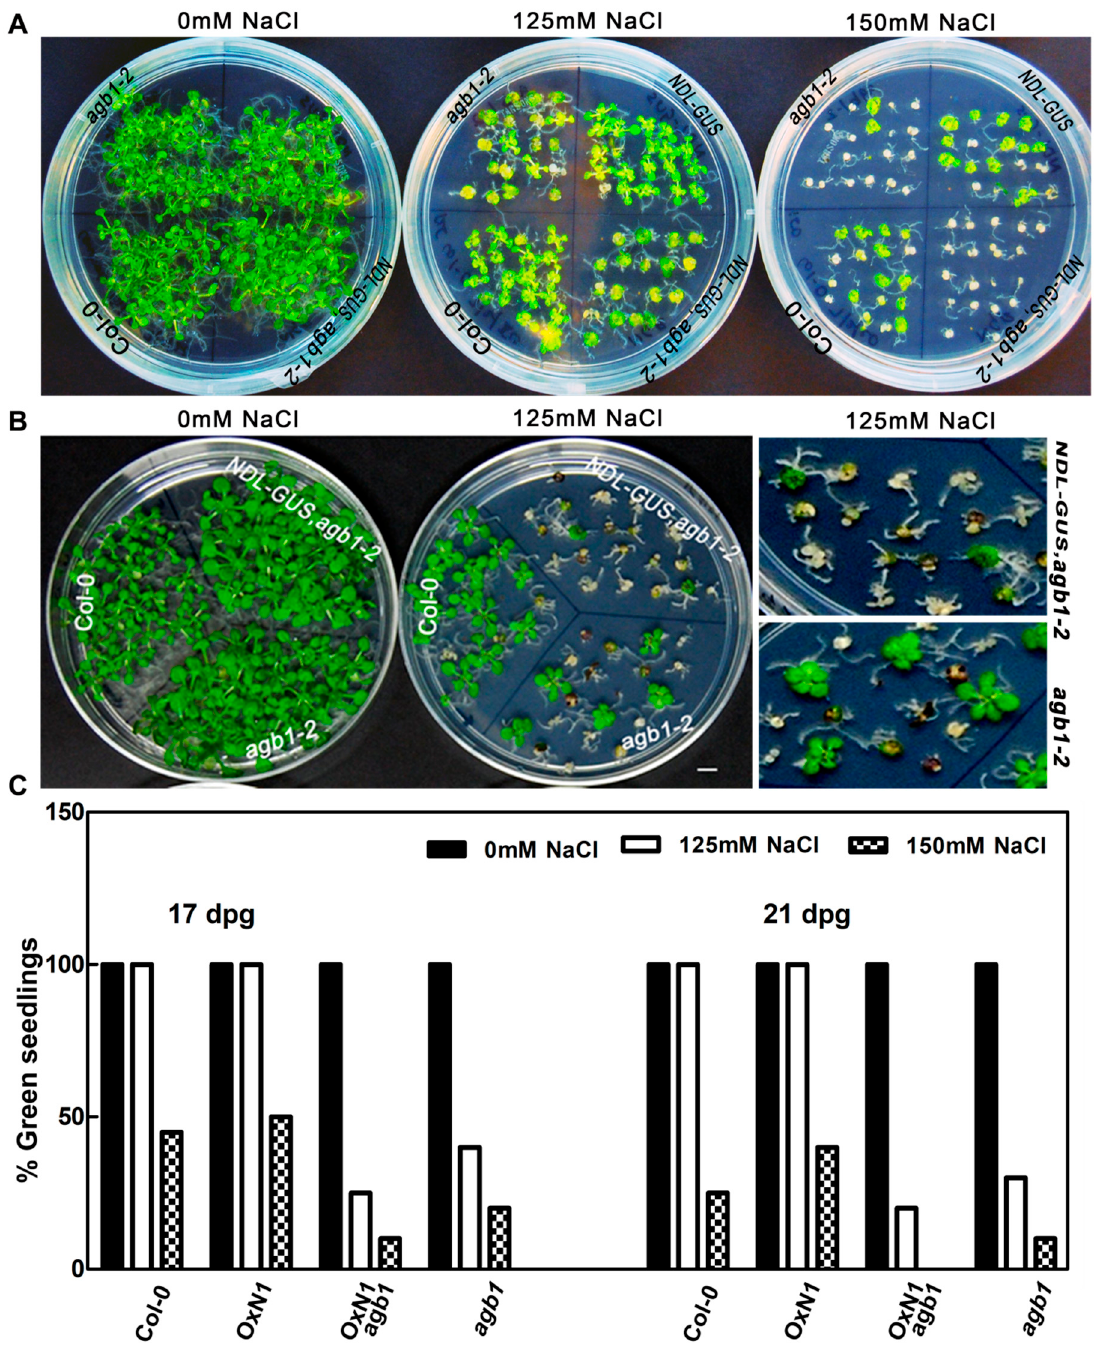
Figure 2. Phenotypic characterization of location of NDL1 in salt stress response. ( A ) Response of NDL-GUS (OXN1) and NDLGUSagb1-2 (OxN1agb1) were compared to Col-0 and agb1-2 . Seedlings were compared and tested for their growth on 125 mM and 150 mM NaCl on day 21. NDL-GUSagb1-2 bleached faster than agb1-2 . ( B ) Phenotypic characterization was also performed for shorter duration and concentration of NaCl (day 17 on 125 mM NaCl) in that case also NDL-GUSagb1-2 showed faster rate or bleaching or whitening compared to agb1-2 (enlarged view also provided). Scale bar for plates in A and B = 0.5 cm. ( C ) Graph showing number of green seedlings in genotypes mentioned above after 17 and 21 days post-germination at different concentration of NaCl. All the experiments were repeated more than four times with 15–20 seeds; a representative graph and image of one such experiment are shown.